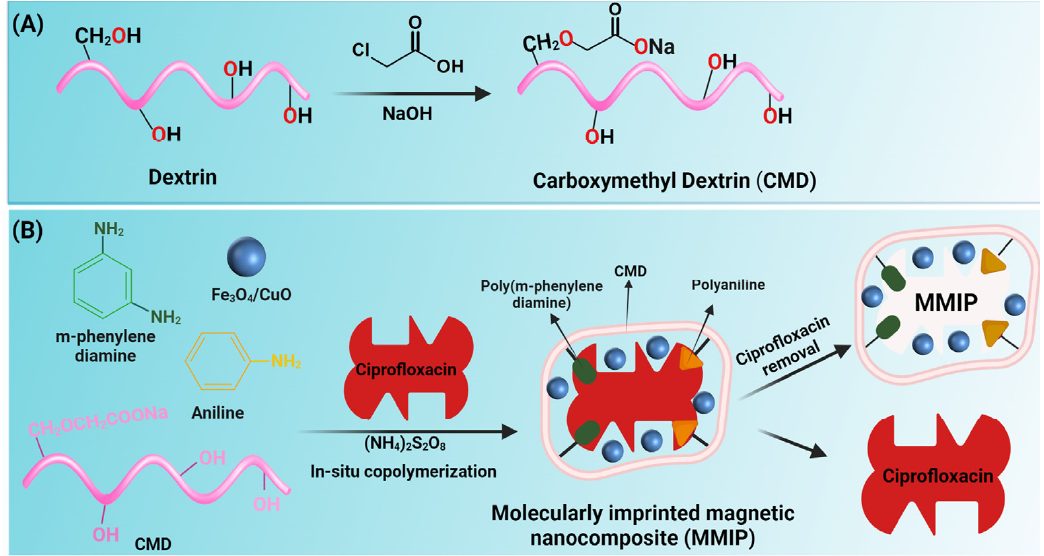
Figure 1. Schematic illustration of the synthesis of carboxymethyl dextrin (CMD) ( A ) and fabrication of magnetic molecularly imprinted polymer (MMIP) ( B ).